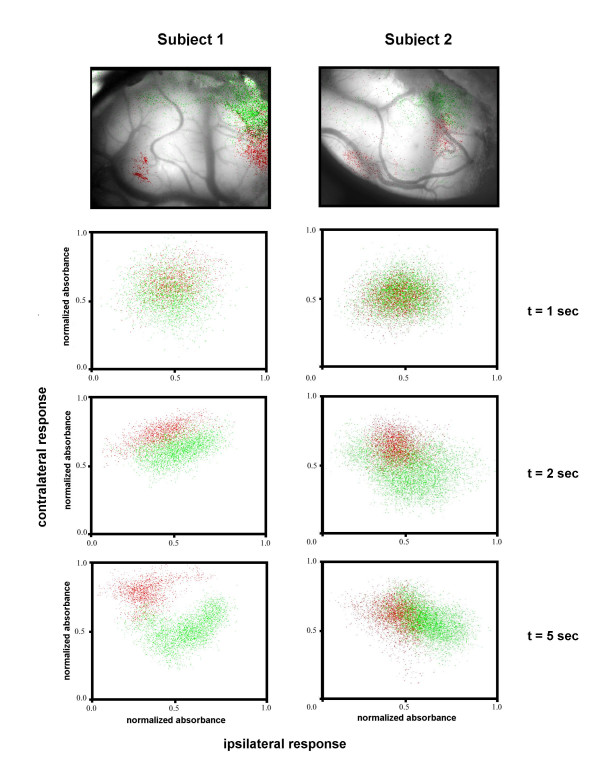
Cluster plots of ipsilateral vs. contralateral response of 2 subjects. For each cluster plot, values of individual pixels are plotted as a function of the response measured at that pixel to the ipsilateral stimulus (horizontal axis) vs. the response measured at that locus evoked by the contralateral stimulus (vertical axis). Colors depict the pixels that maximally responded to ipsilateral (green) and contralateral (red) stimulation. Cluster separation follows the same trend as the time course shown in Figure 4. After 5 seconds, the activity of the responding population has diverged into two distinct clusters. Reference images at top are at same orientation as the reference images in Figure 1.